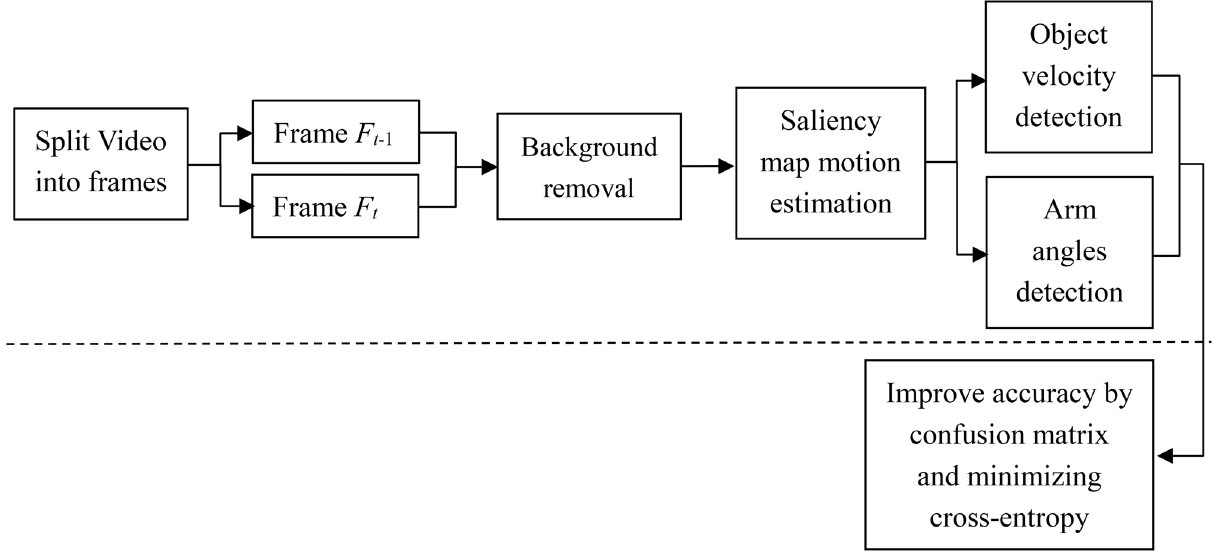
Figure 1. A general overview of the proposed motion recognition